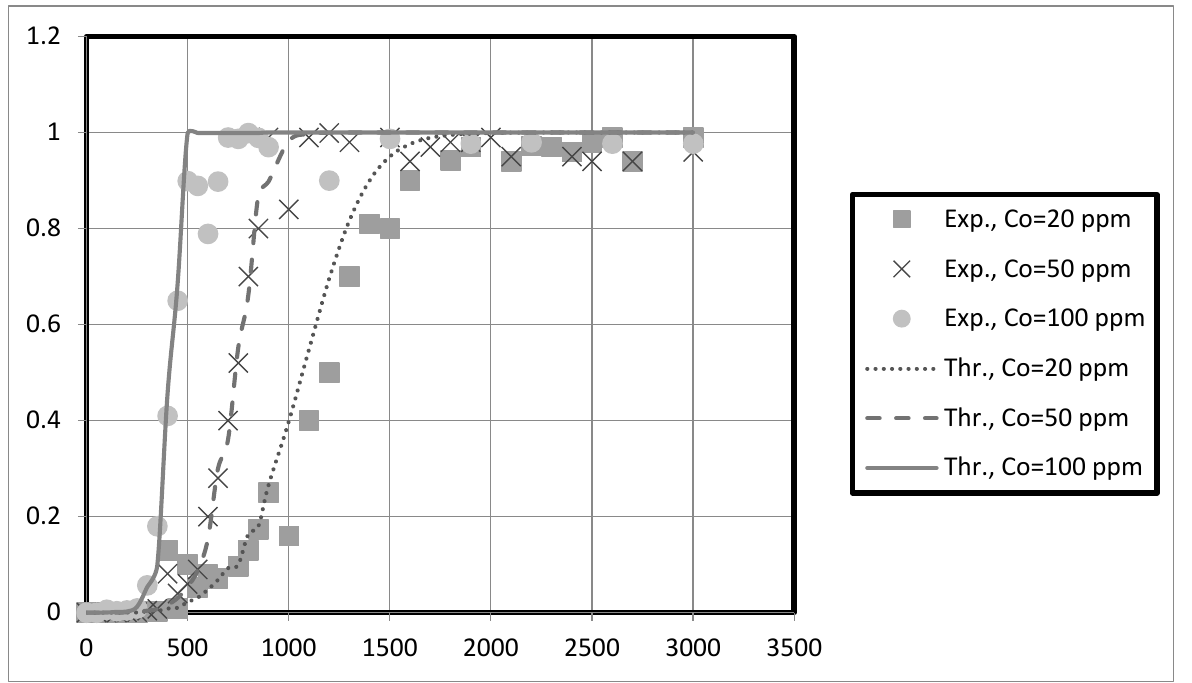
Figure 14. Axial pore di ff usion model fi t of the fi xed-bed breakthrough curve for a nickel at di ff erent initial solution concentrations. Conditions: h = 0.1 m, us = 0.00473 m/s, kf = 0.000252 m/s, Dp = 2 × 10 − 9 , Dax = 3.53 × 10 − 6 m 2 /s, eb = 0.42, r = 0.000175